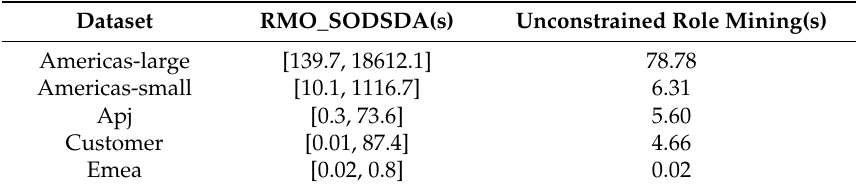
Table 15. Comparison of execution